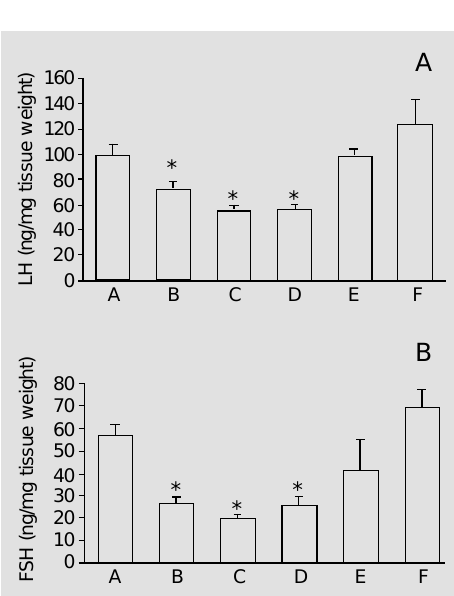
Figure 4 - Effects of administra- tion of different R-PIA doses on LH (A) and FSH (B) secretion stimulated by phospholipase C (0.5 IU/ml). The preparation con- ditions are the same as de- scribed in the legend to Figure 1. Data are reported as means ± SEM (N = 5). *P<0.01, + P<0.05 compared to control (A) (Newman-Keuls test).